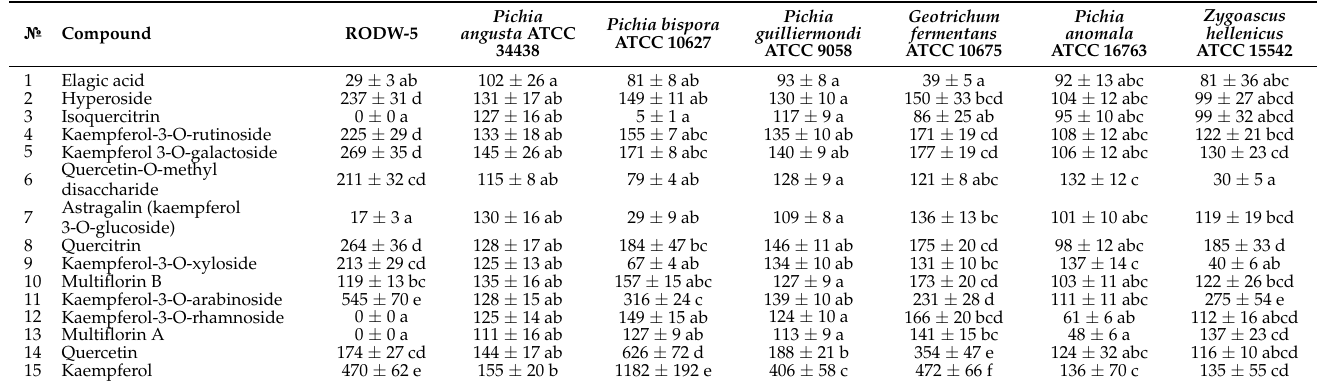
Table 1. Relative amounts of 15 identified compounds in RODW phenolic extracts obtained after RODW fermentation with RODW-5 isolate and common industrial yeast strains. The relative amounts are presented as percentages of the amount of each compound in unfermented RODW analyzed in parallel. Each value is an average ± SD of the results from three independent RODW cultivations followed by phenolic extraction and HPLC